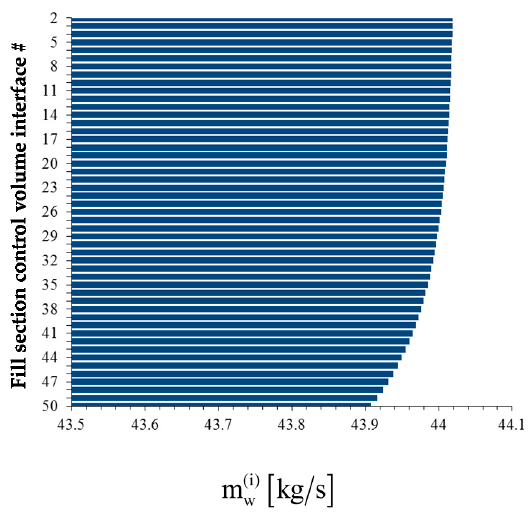
( i ) ( i = 2,...,50 ) , at the exit of each control volume w , m , ( 2,...,50) = i , at the exit of each control volume w